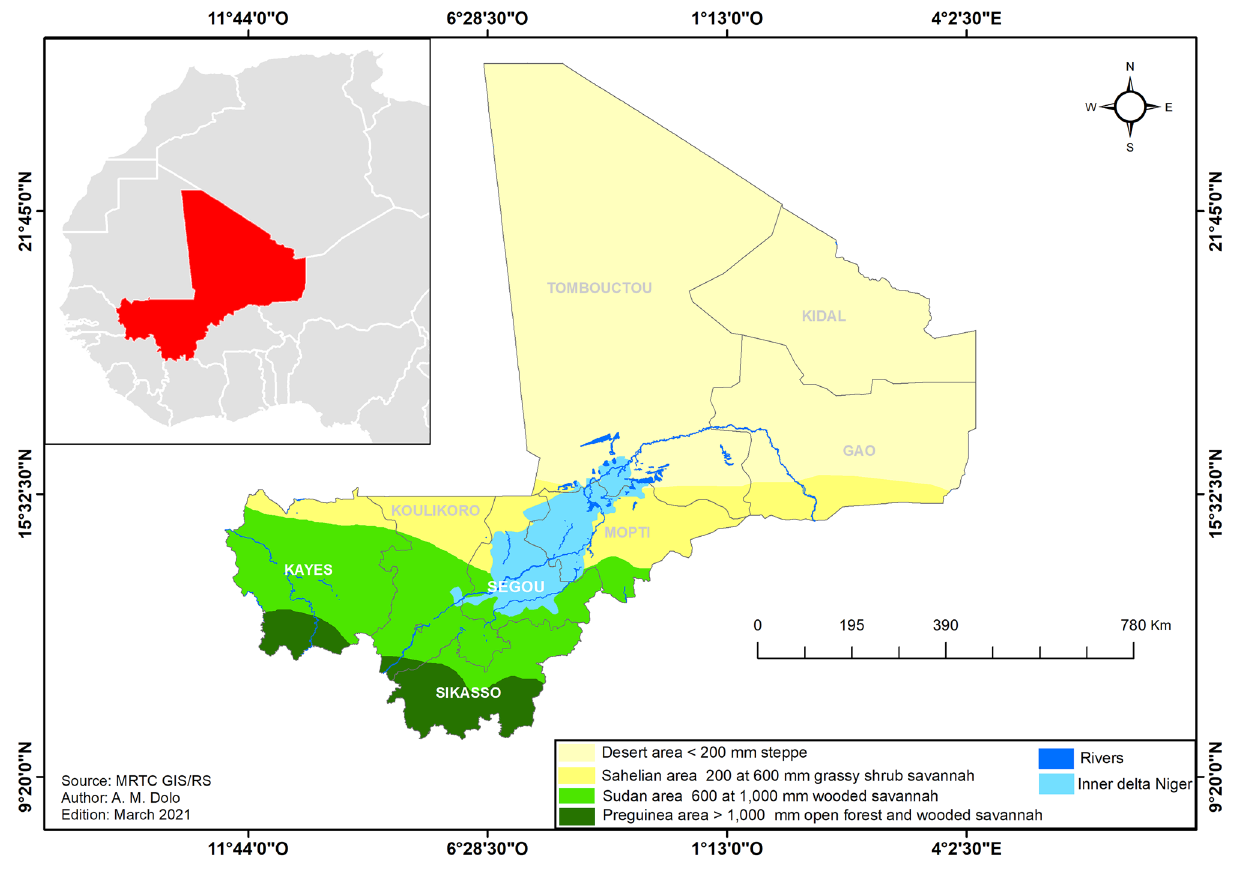
Figure 1. Ecoclimatic zones of Mali (Source: MRTC GIS/RS).